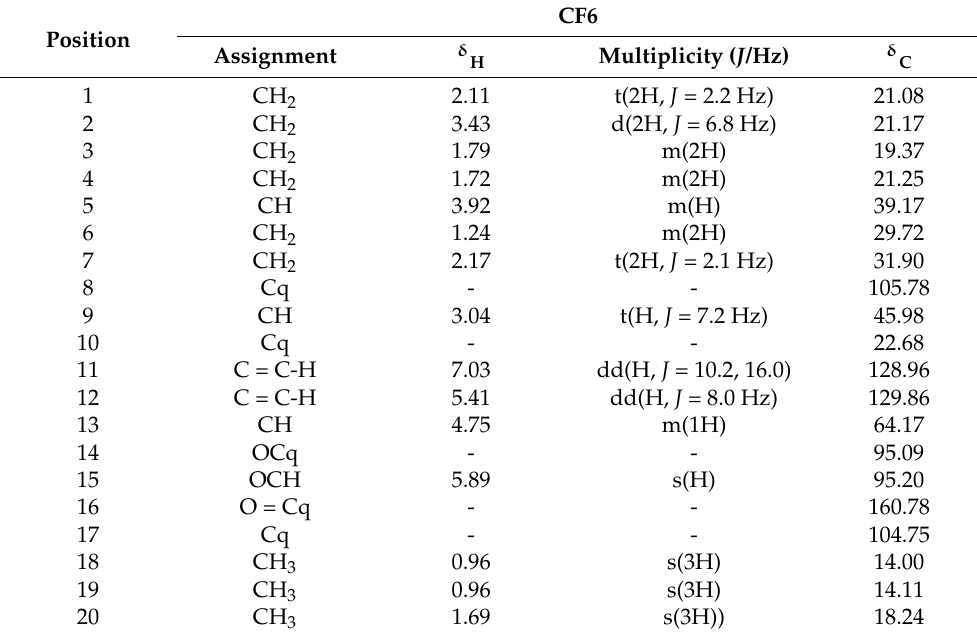
Table 1. 1 H NMR (400 MHz,) and 13 CNMR (150 MHz) data for CF6 in CDCl 3 .